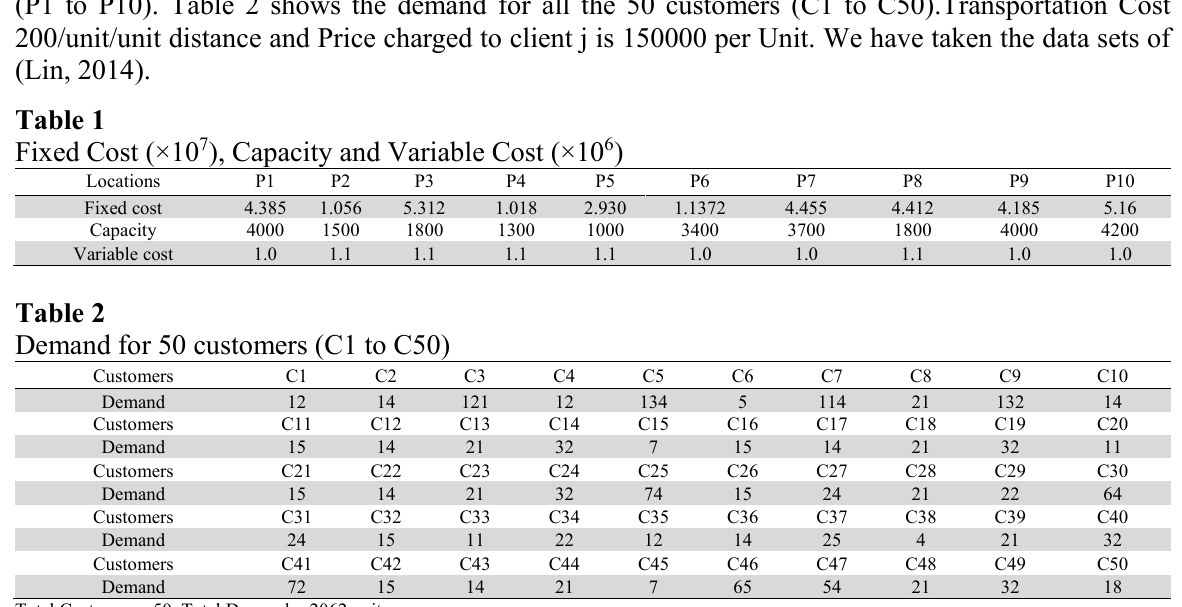
Results : Table 3(a) to Table 3 (d) shows the result of the numerical example 1 for the cases without clustering and clustering for number of clusters = 2-5 when facility and variable cost are different. Table 3(a) Number of clusters = 2 Without Clustering With Clustering Locations